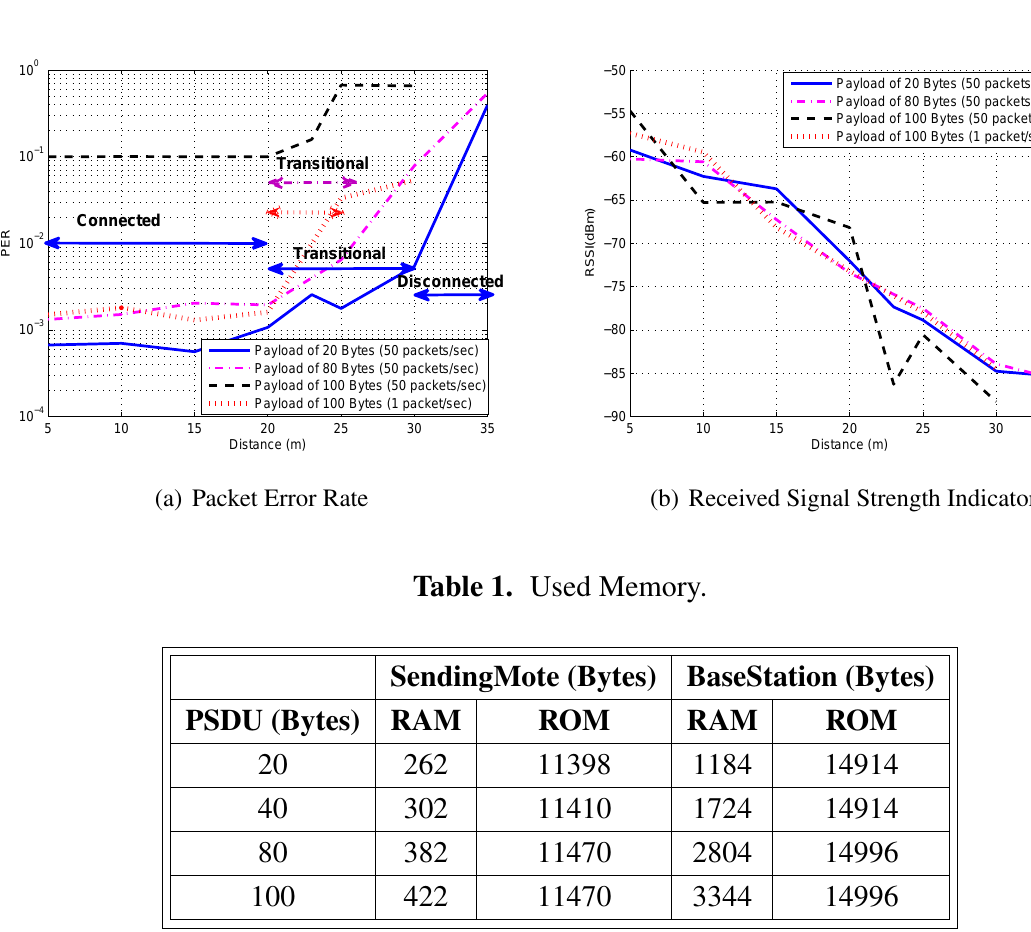
Figure 7. PER and RSSI against distance for different payload sizes. Corridor Scenario.